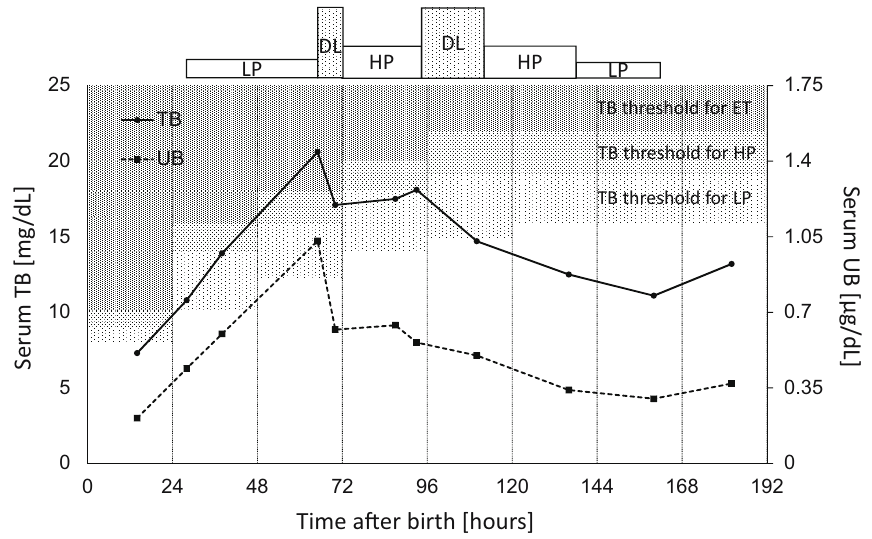
Figure 2: Clinical course of jaundice management. A male infant born at 33 weeks gestation with a birth weight of 2,028 g developed